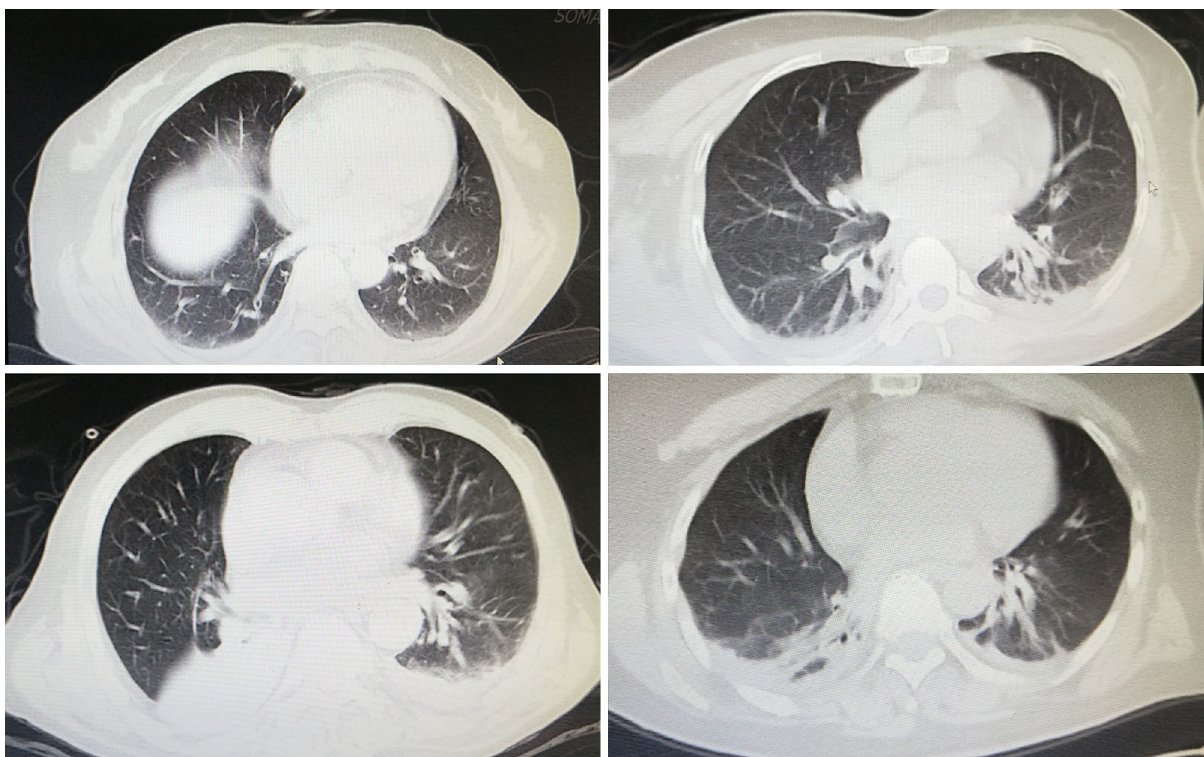
Figure 1. The first postoperative chest CT image showed bilateral pulmonary imaging abnormalities after craniotomy of brain tumor.